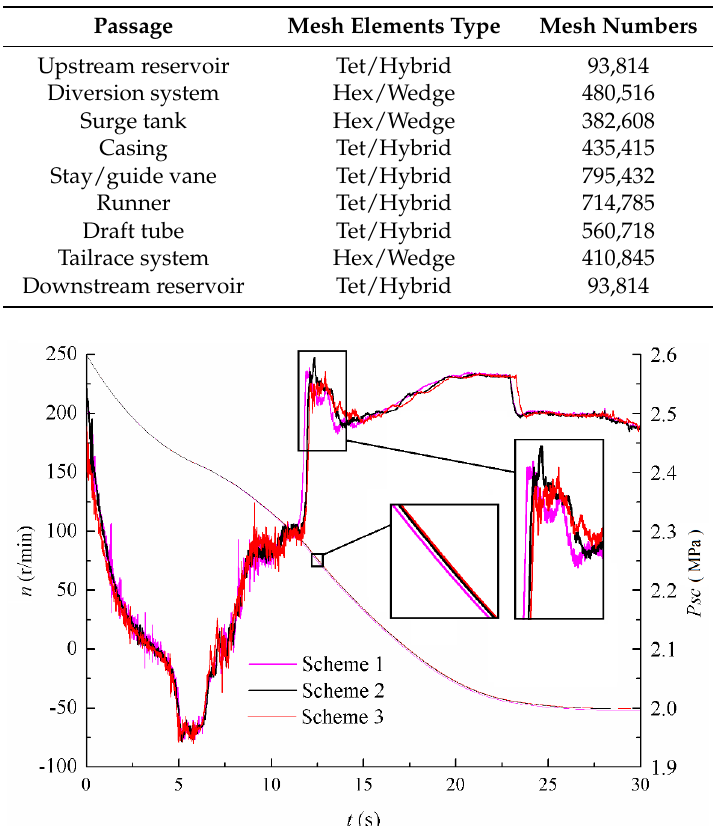
Table 1. Mesh subdivision schemes of the PSH station.